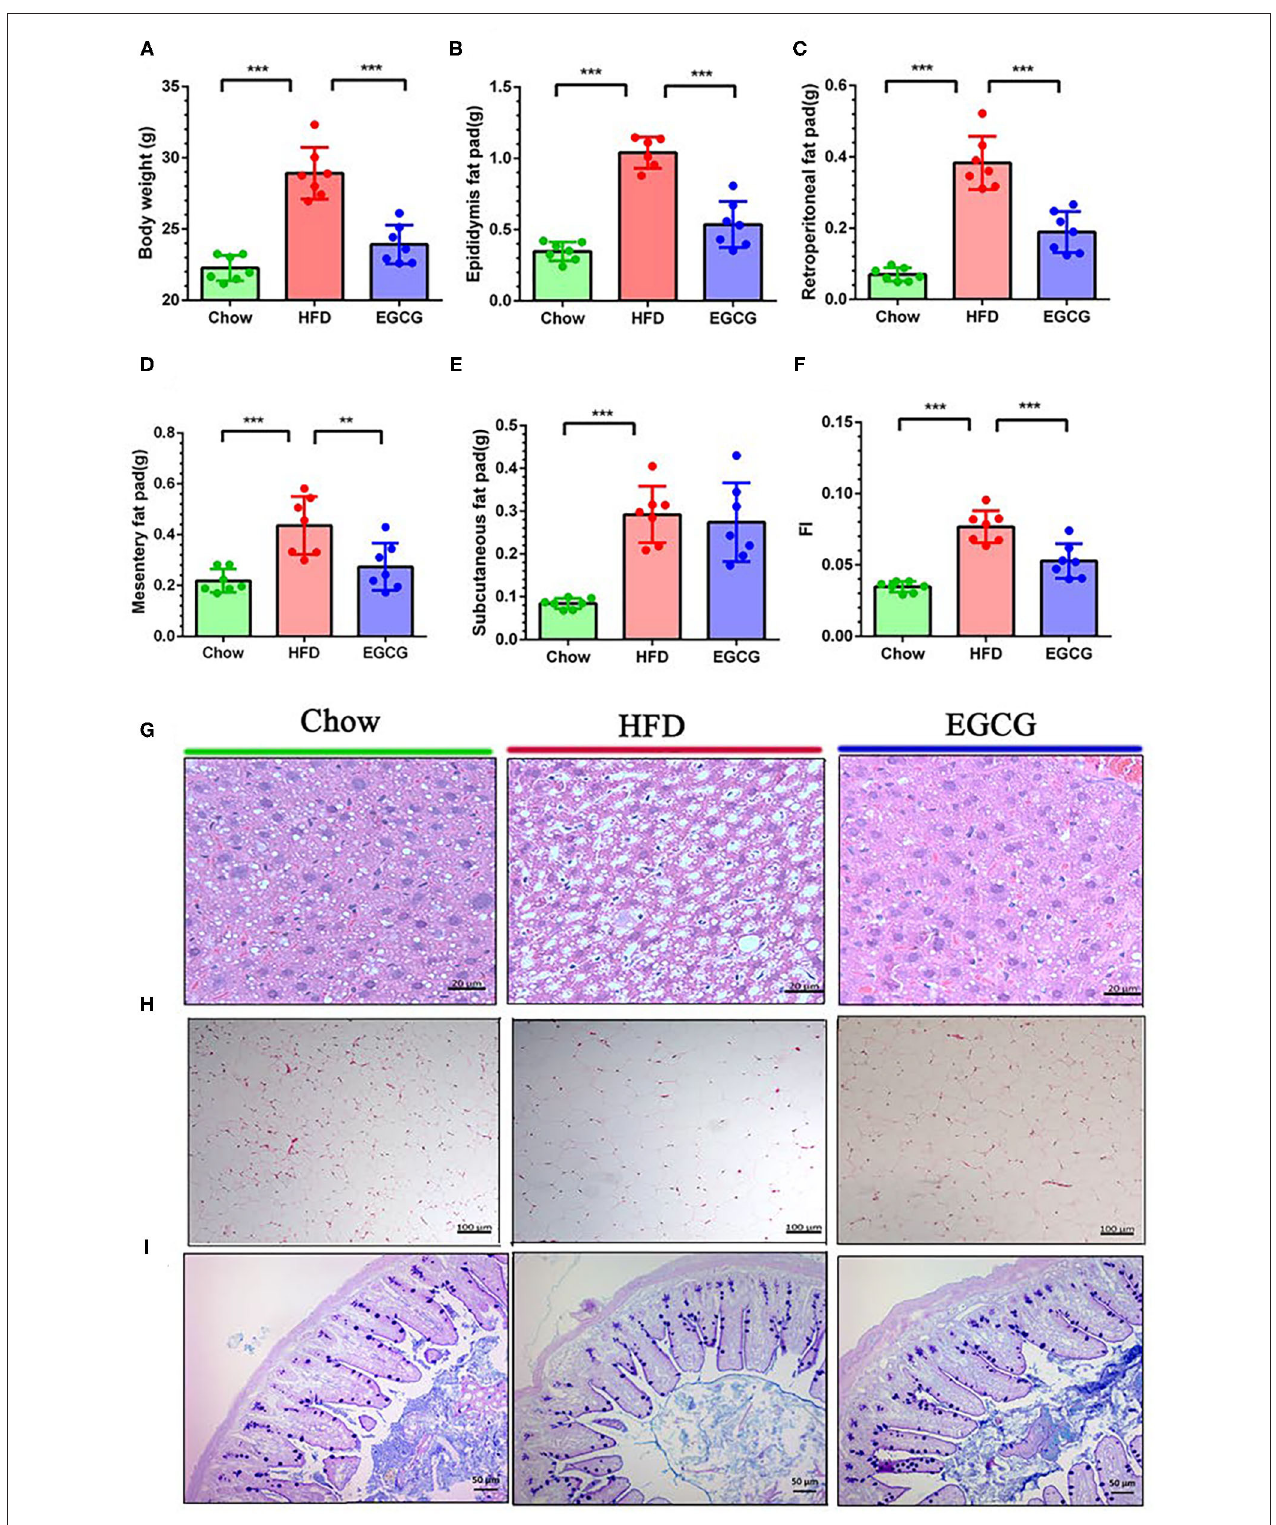
FIGURE 1 | Body compositions and histopathological changes. (A–F) Body weight, epididymis fat pad weight, retroperitoneal fat pad weight, mesentery fat pad weight, subcutaneous fat pad weight, and fat index (FI) (total fat pad weight/body weight). (G) The parenchymal hepatic cells were stained with H&E and observed at 40 × . (H) The epididymis fat pads were stained with H&E and observed at 10 × . (I) The ileal sections were stained with Alcian blue/periodic acid-Schiff (AB/PAS) and observed at 20 × . Data were presented as mean ± SD. Statistically, a significant difference was analyzed by one-way ANOVA followed by Dunnett’s multiple comparisons tests. ** p < 0.01, *** p <